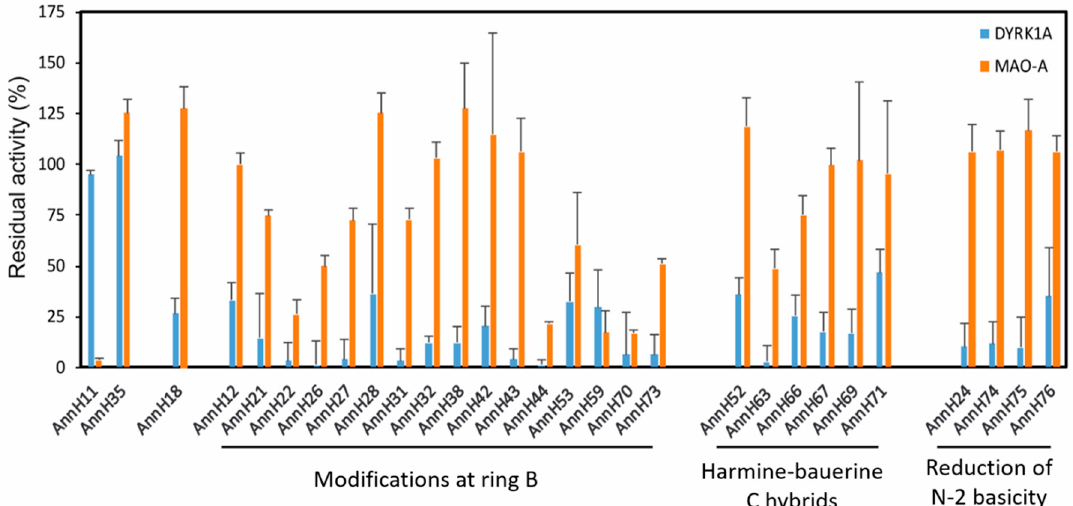
Figure 3. Inhibition of DYRK1A and MAO-A by selected harmine analogues. The diagram summarizes the screening results of the most relevant inhibitors from Table 1 to illustrate the different degrees of selectivity for DYRK1A. Shown are inhibitors that reduce DYRK1A activity by at least 50%. For comparison, AnnH11 is included as an example for MAO-A selective inhibitor and AnnH35 as a non-selective inhibitor. Columns reflect the residual enzyme activities of DYRK1A (blue) and MAO-A (orange) after incubation with the indicated compounds at a concentration of 1 µM (means and SD).